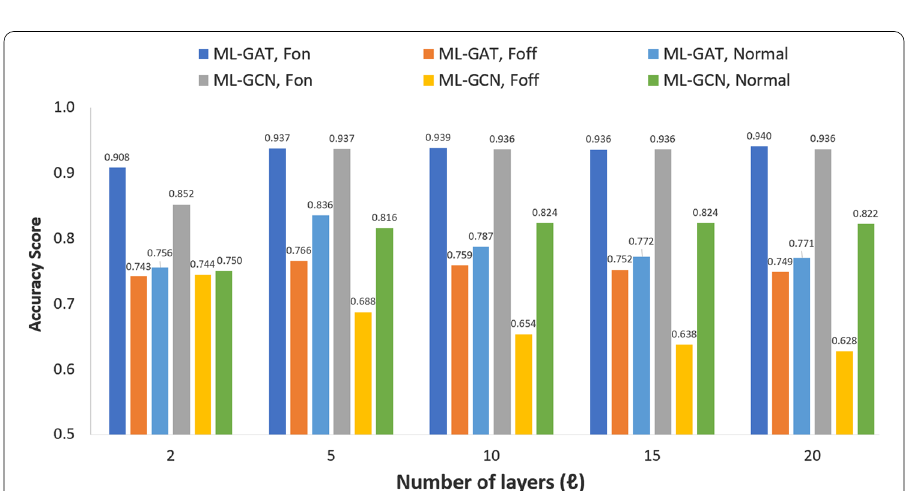
Fig. 7 Graphical representation of the performance of our framework on the Koumbia multilayer